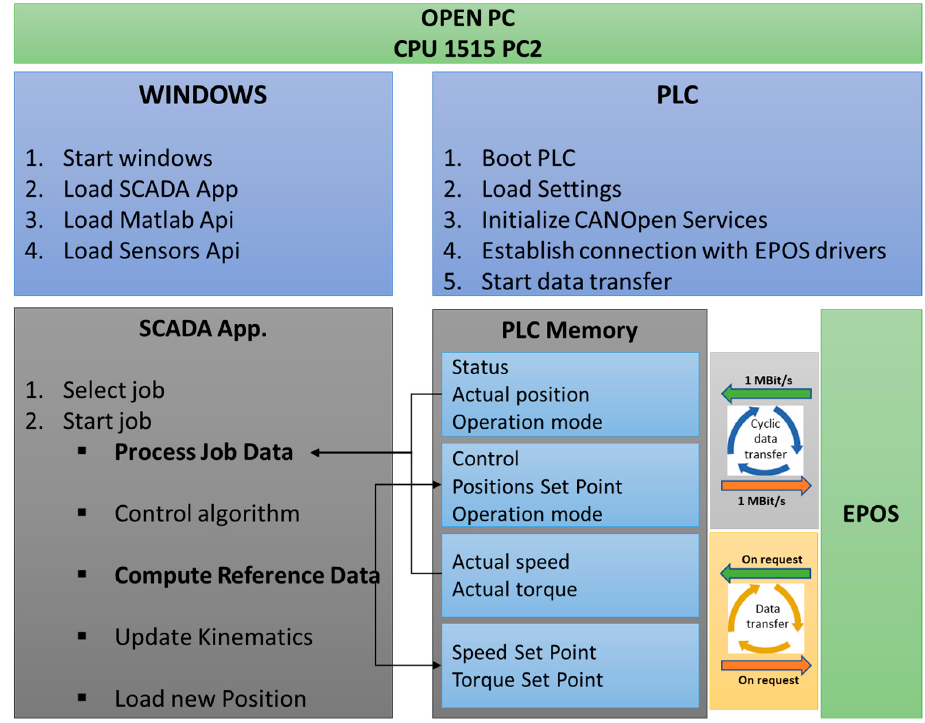
Figure 9. Detailed control architecture for controlling the CardioVR-ReTone exoskeleton.